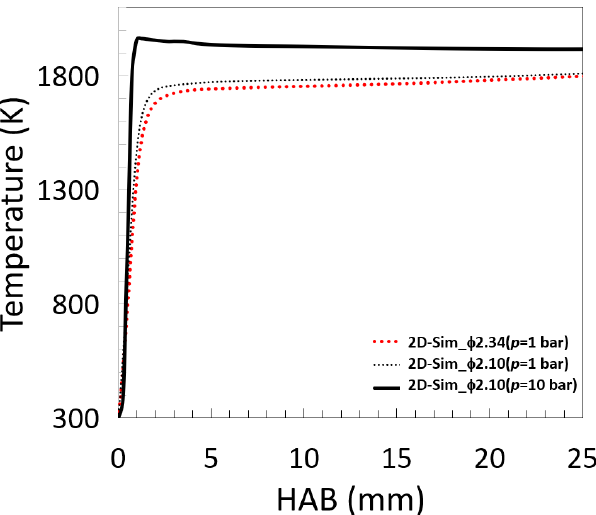
Figure 9. Predicted centerline flame temperature (K) by 2D simulation of C 2 H 4 /air flames at p = 1.01 (dotted lines) and 10 (solid line) bar for ϕ = 2.1 (in black) and at p = 1.01 bar for ϕ = 2.34 (in red).